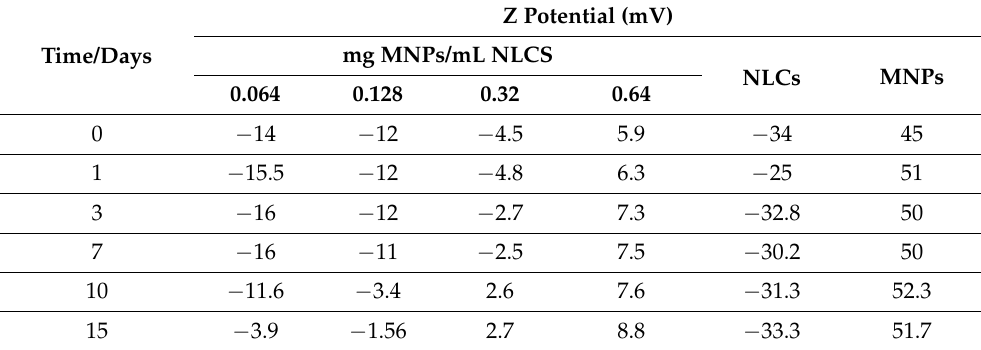
Table 1. Evolution of Z potential for nanosystems prepared with increasing proportions of MNPs, as a function of storage